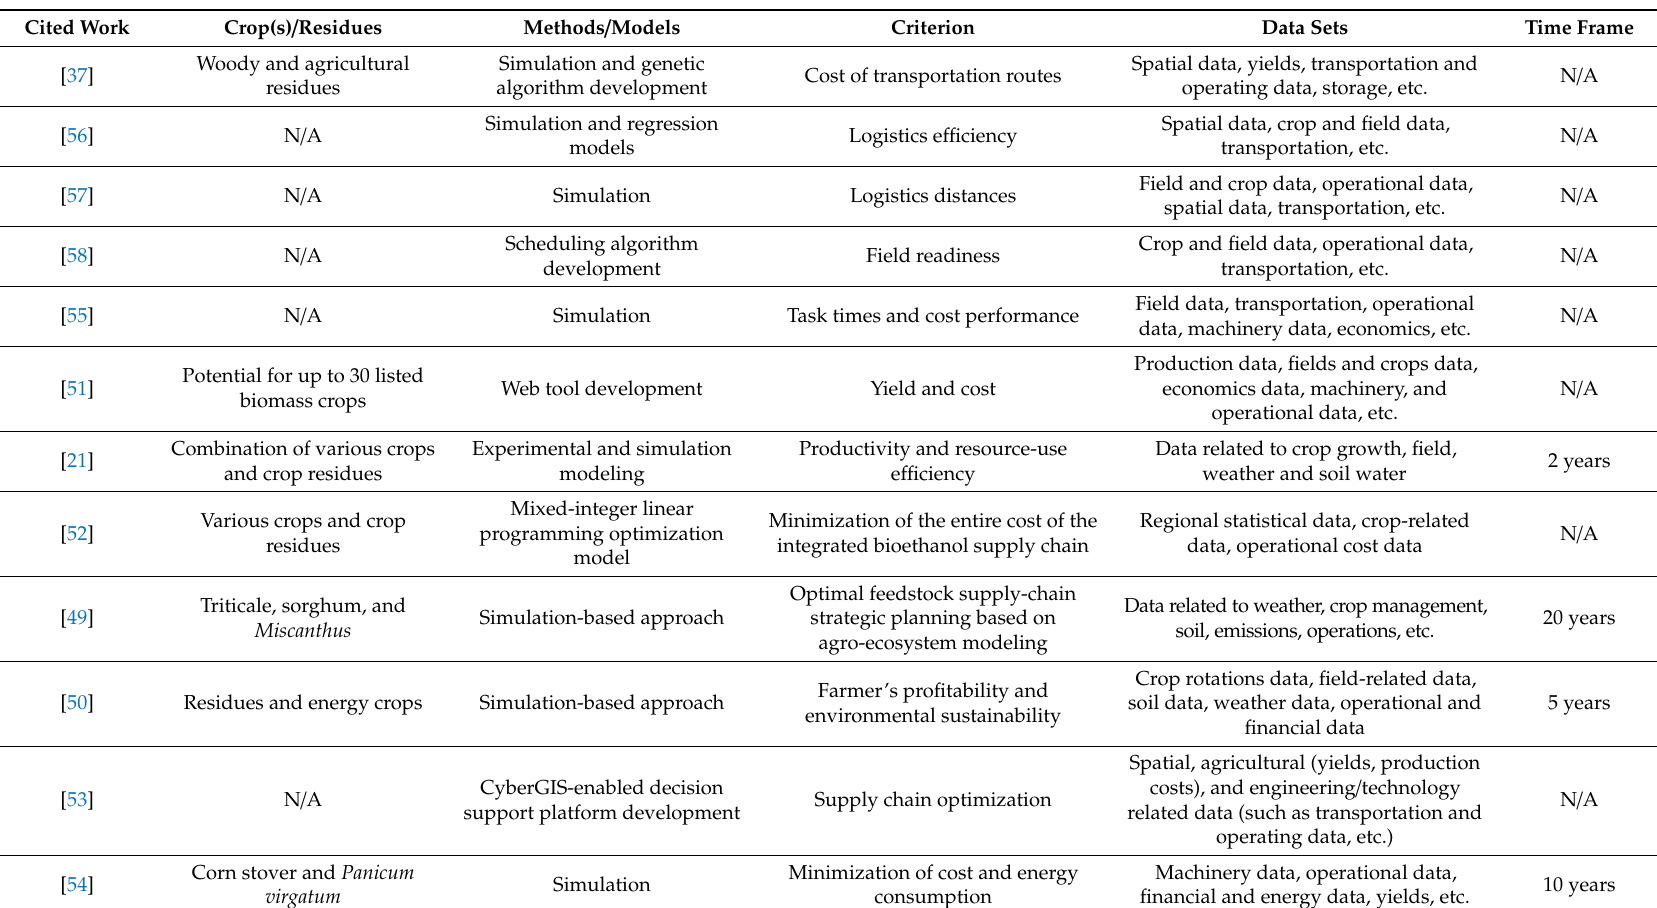
Table 4. Multiple-type biomass cited studies classified by crop and